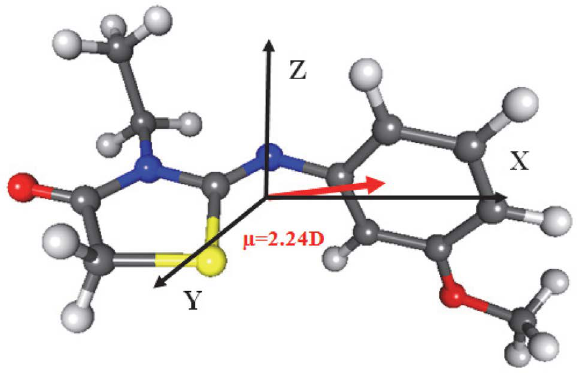
Figure 7. Orientation of the molecular dipole moment from DFT